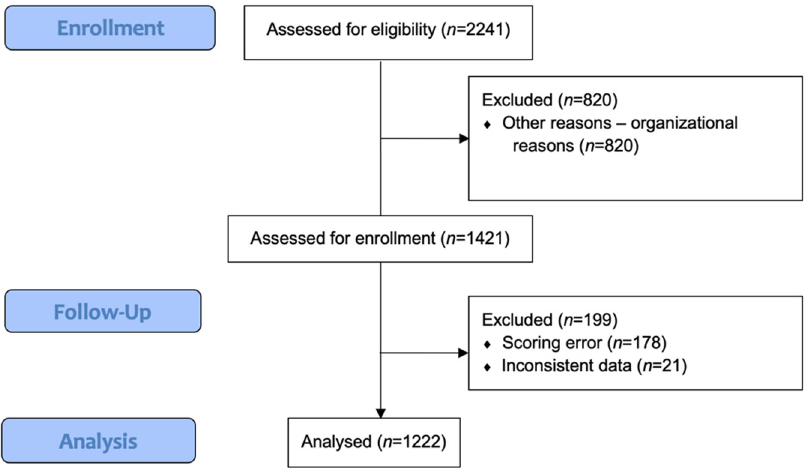
Figure 1. Figure 1. Flowchart. Table 1. Demographics.